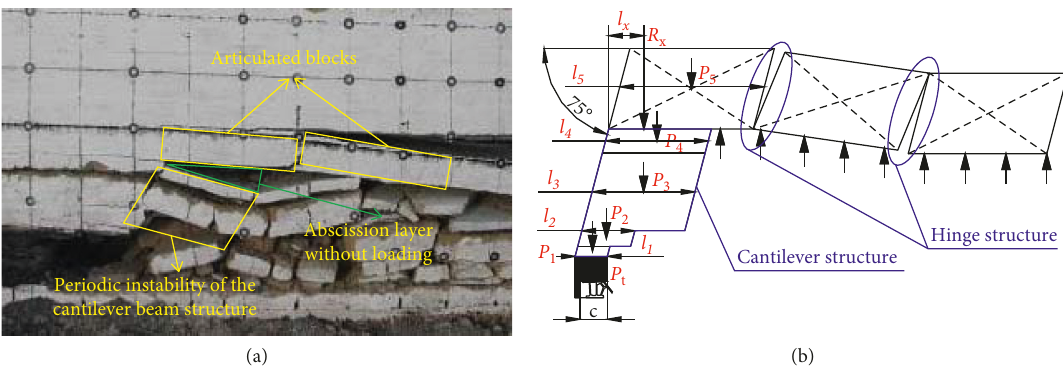
Figure 5: Structure characteristics of the combined cantilever beam-hinge structure of overlying